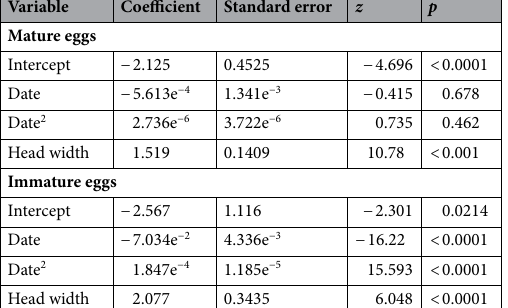
Table 1. Results of second-order polynomial regression for effects of Date (number of days since January 1), Date 2 and Head width on the numbers of immature and immature egg loads in field-captured P. downsi